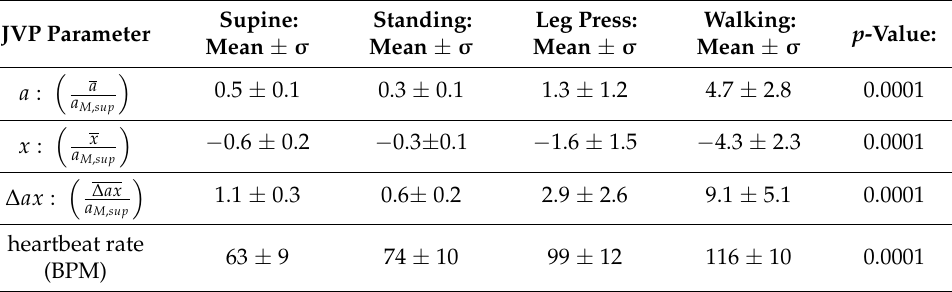
Table 1. The dimensionless normalized values obtained for a , x and ∆ ax parameter, as well as the heartbeat rate calculated during static (supine and standing) and dynamic (leg press and walking) exercises.